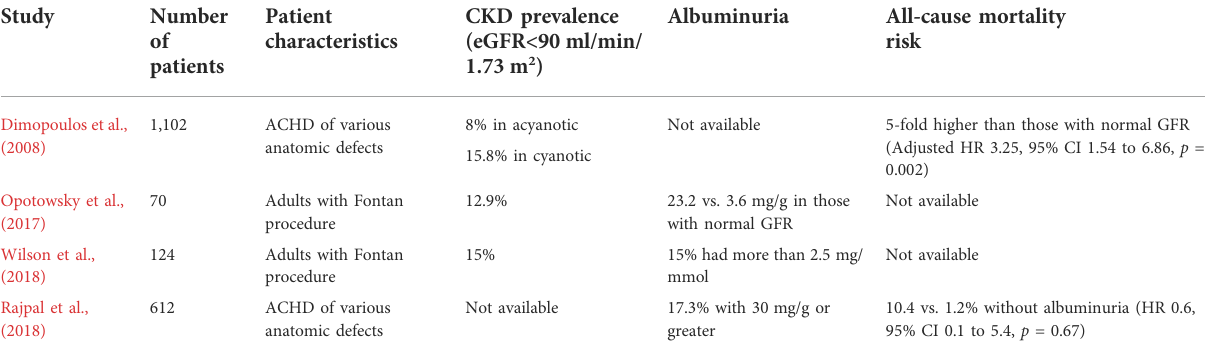
TABLE 1 Summary of the studies in the literature about CKD in adult patients with CHD.